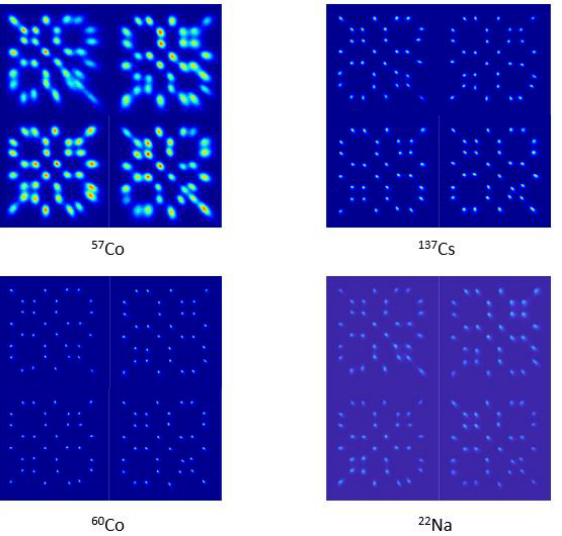
Figure 6. The detector ’ s measured flood histogram of 57 Co, 137 Cs, 60 Co, and 22 Na point sources.